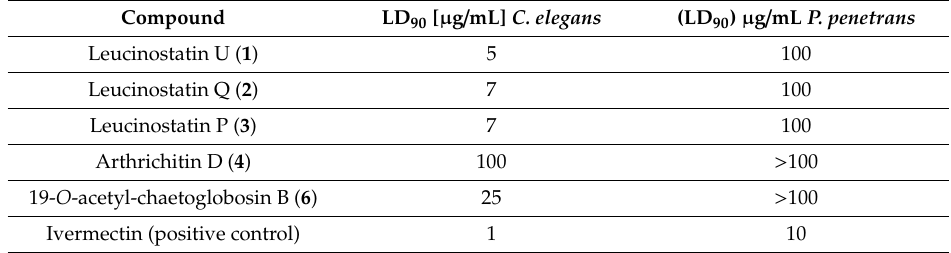
Table 1. Nematicidal activities of 1 – 4 against plant parasitic ( Pratylenchus penetrans ) and free-living ( Caenorhabditis elegans ) nematodes in the microtiter plate assay